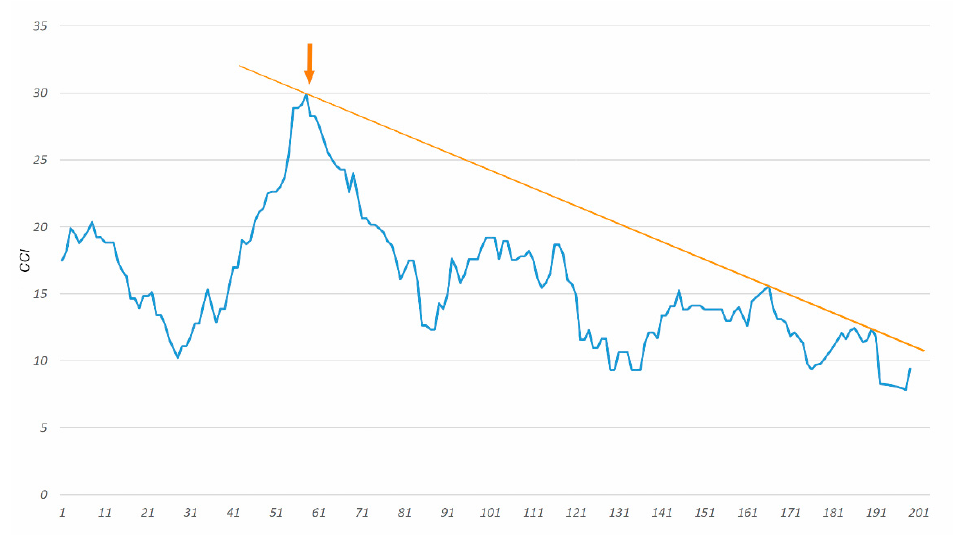
Figure 4. Moving average of estimated risk of complications according to comprehensive complication index (cut off 40). The x-axis represents the operation number.